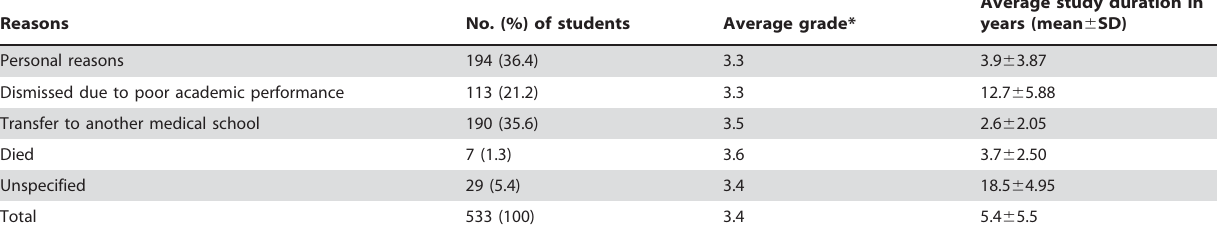
Table 1. Causes of attrition.